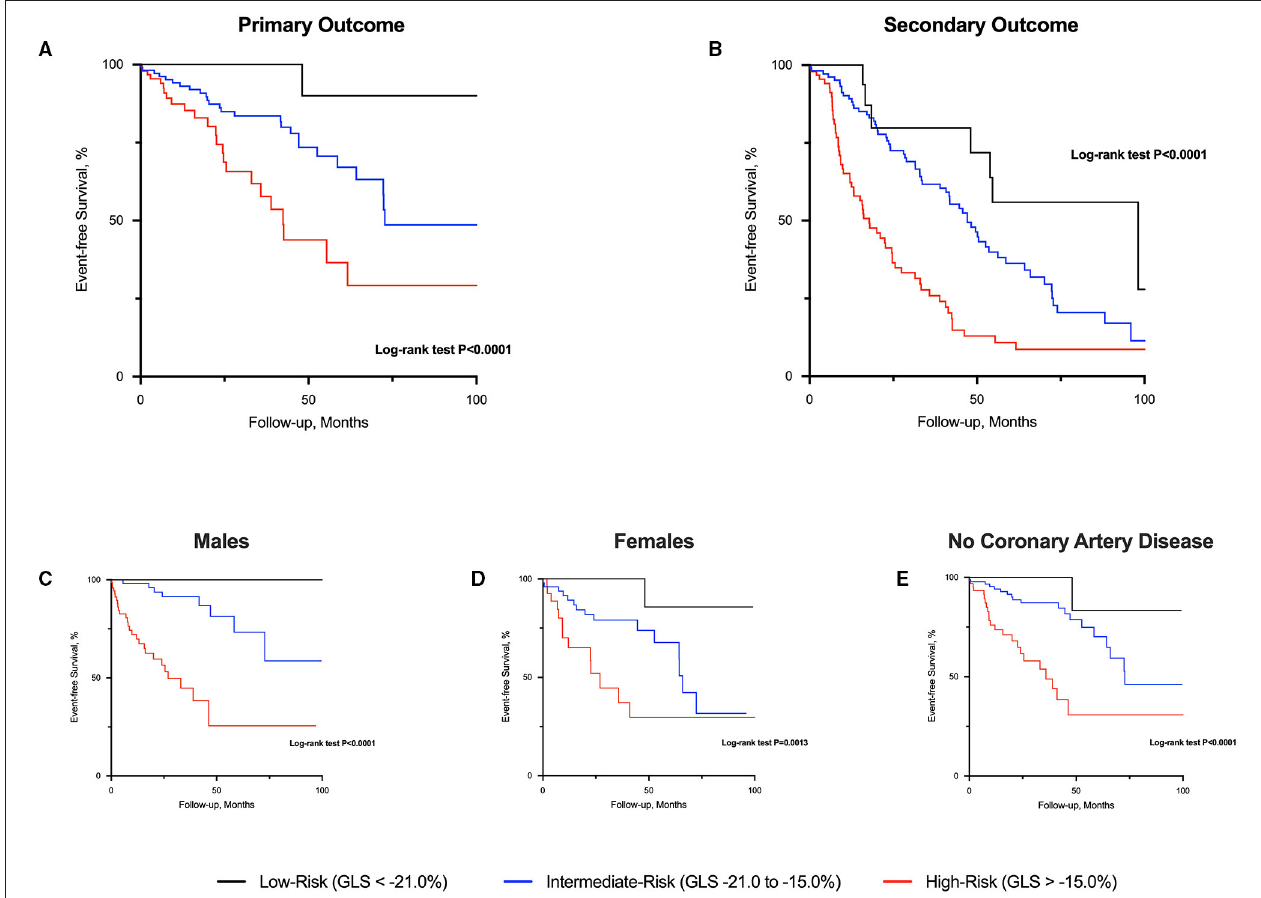
FIGURE 2 | Event-free survival curves in patients with aortic stenosis risk-stratified by global longitudinal strain. High-risk patients with aortic stenosis (global longitudinal strain; GLS > − 15.0%) had worse prognosis compared to those at intermediate and low-risk (GLS < − 21.0%) for both primary (A) and secondary (B) outcome. Similar prognostic findings were observed regardless of sex (C,D) and excluding those with coronary artery disease (E)